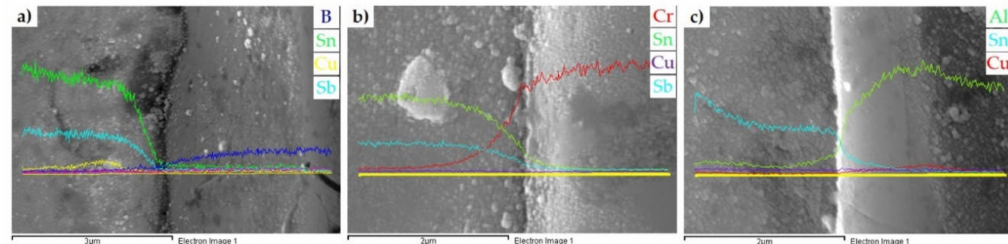
Figure 9. Line scan of the interface between Sb-based Babbitt metallic matrix: ( a ) B 4 C; ( b ) Cr 2 C 3 , and ( c ) Al 3 O 2 .